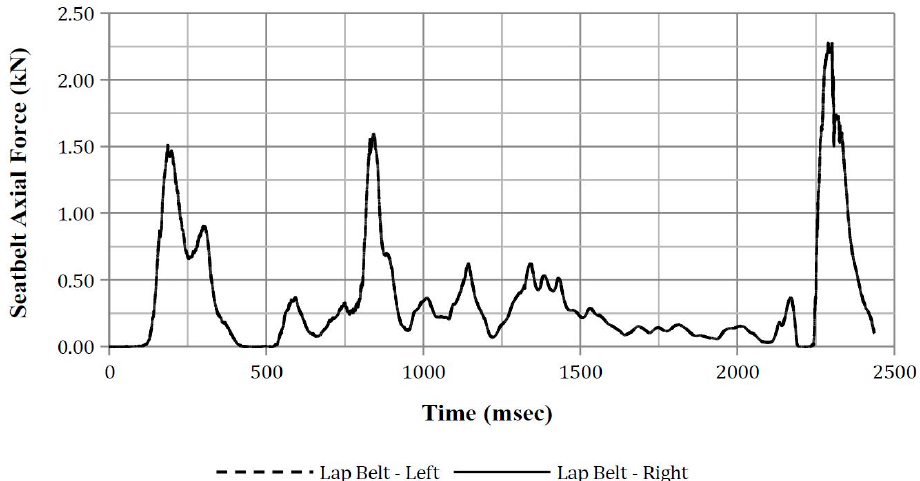
Figure A34. ATD Position 5 lap belt axial force.